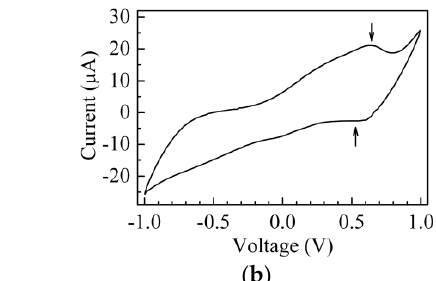
Figure 4. ( a ) Current-voltage loop of a cell obtained using the electrochemically derived copper-chitosan complex as the electrode; current-voltage plot of the Au/chitosan:CuOx/chitosan/Au cell ( b ).